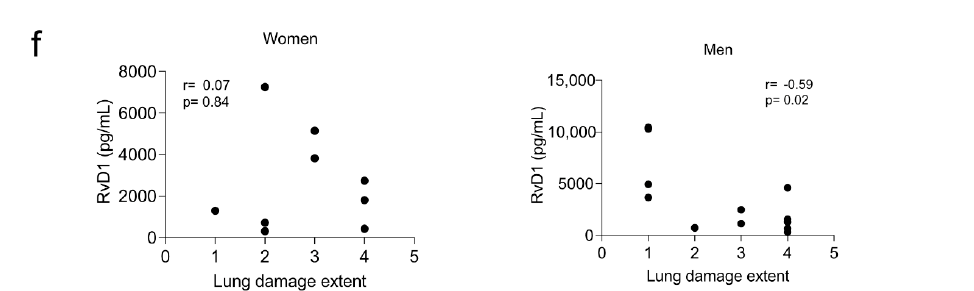
Figure 7. PGE2 and RvD1 negatively correlated with lung damage in men. Principal components (PC) analysis was performed using the following variables: sex, PGE2, LTB4, RVD1, Mar1, estradiol, MDA, TNF α , IL8, IL6, RvD1/PGE2 ratio, RvD1/LTB4 ratio, and Mar1/RvD1 ratio. Patients with missing data were excluded. PC Scores ( a ) and PC Loadings ( b ) are depicted. Spearman’s correlation matrix was performed for the parameters influencing the PC1 and the clinical variables age, BMI, smear grade, and lung damage extent for both women ( c ) and men ( d ). Rho’s values are depicted within the heat maps; * indicates unadjusted p < 0.05 annotated only in the inferior half of the matrix. Correlation plots of PGE2 ( e ) and RvD1 ( f ) with lung damage extent in women and men are depicted.